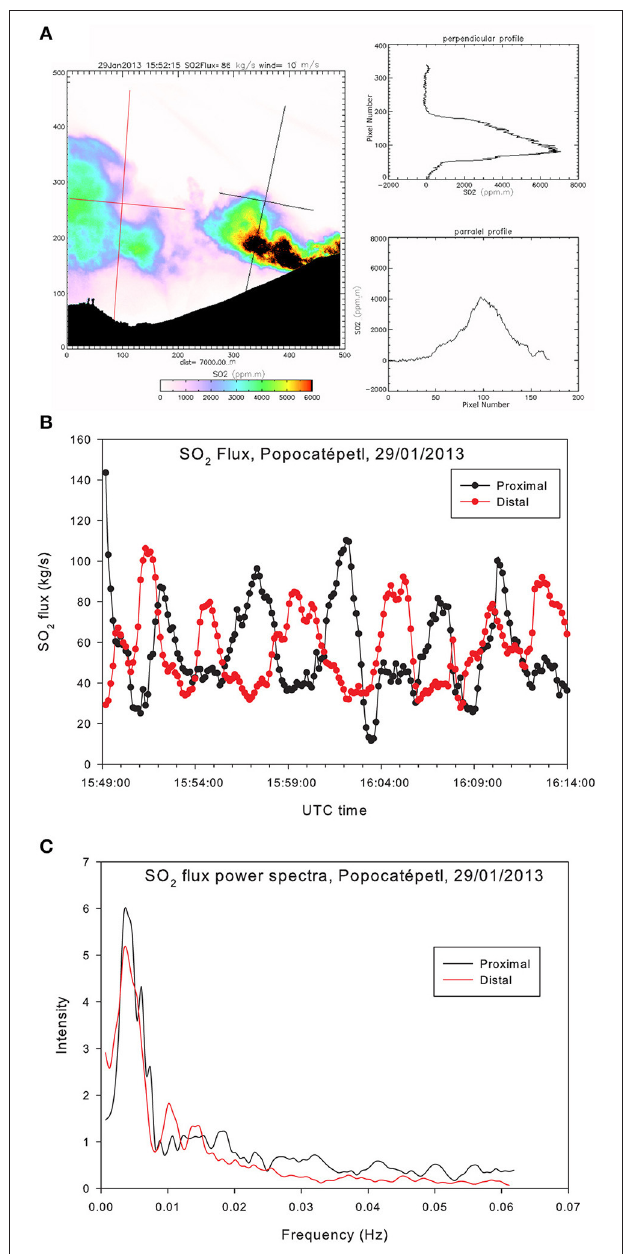
FIGURE 7 | Comparison between SO 2 flux measurements obtained very close and further downwind of the volcano. (A) Distribution map of the SO 2 in the plume, with the proximal transect shown in black (traced ∼ 200m downwind of the crater), and the distal transect shown in red ( ∼ 2.3km from the crater). (B) Respective time series of SO 2 measured on the two transects. (C) Respective power spectra computed from these time series. The spectra of the distal time series shows a less prominent peak at the puffing frequency, and higher power distribution at the lower frequencies, indicating a smoothing of the puffs with